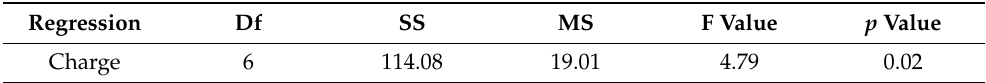
Table 10. ANOVA, DF, SS, MS, and F-Value for the charge of the NPs.